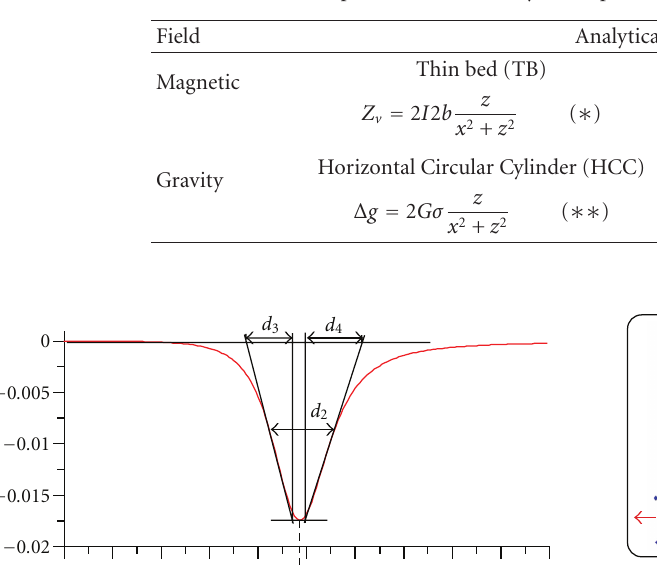
Table 1: Comparison of some analytical expressions for magnetic and gravity fields.